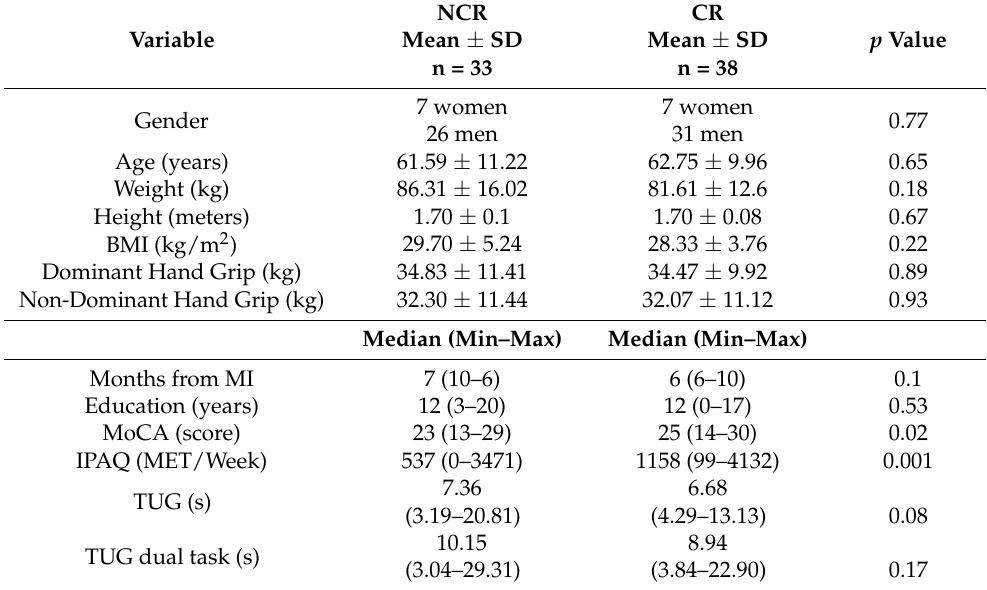
Table 1. Participant